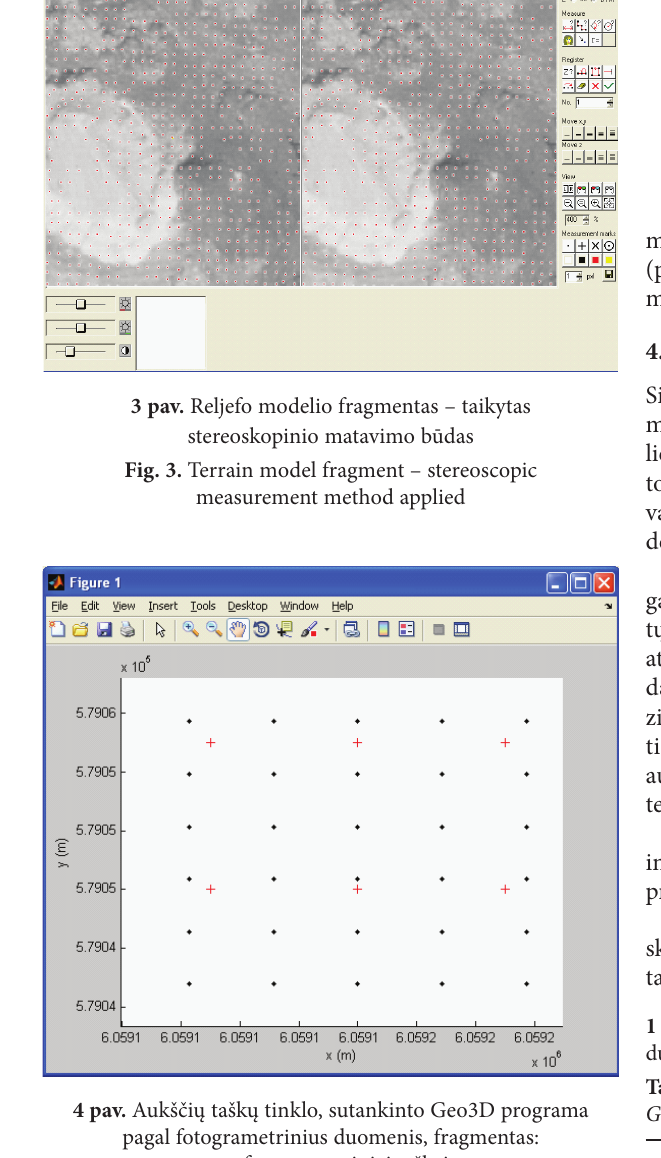
Fig. 4. F ragment of the network of height points multiplexed